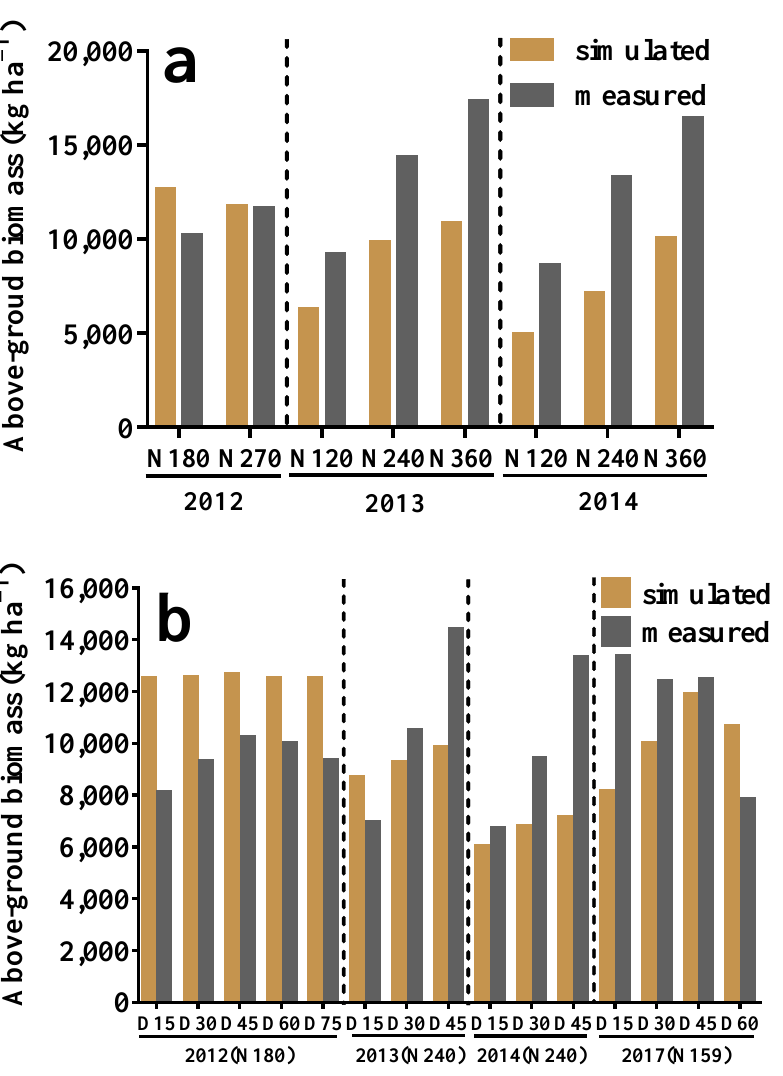
Figure 8. Measured and simulated above-ground biomass under different nitrogen rates ( a ) and planting densities ( b ) of Huayouza62.